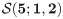
Comparison of mutual information of two consecutive samples taken at the same location (S(5;1,2)) parametric in the time interval between the two samples.Arrow indicates time at which the second sample provides 80% of the asymptotic value. Color code as in Fig 3.